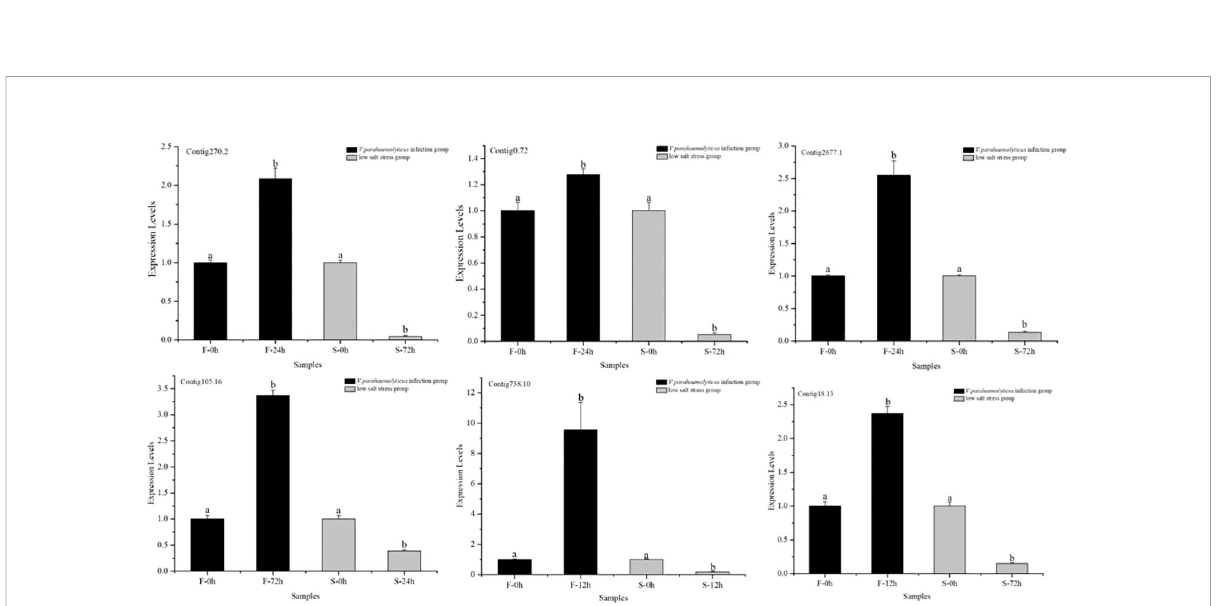
FIGURE 8 qPCR validations of transcriptomic data. Black was for V.parahaemolyticus infection group, gray was for low salt stress group. Different letter (a,b) in the picture indicate signi fi cant difference (P<0.05).